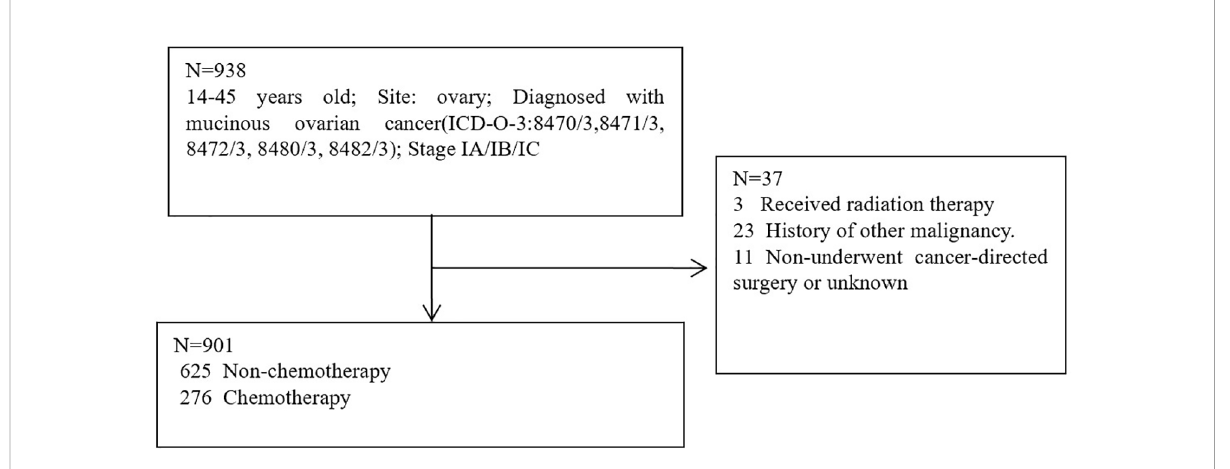
FIGURE 1 Flowchart of screening data from the SEER